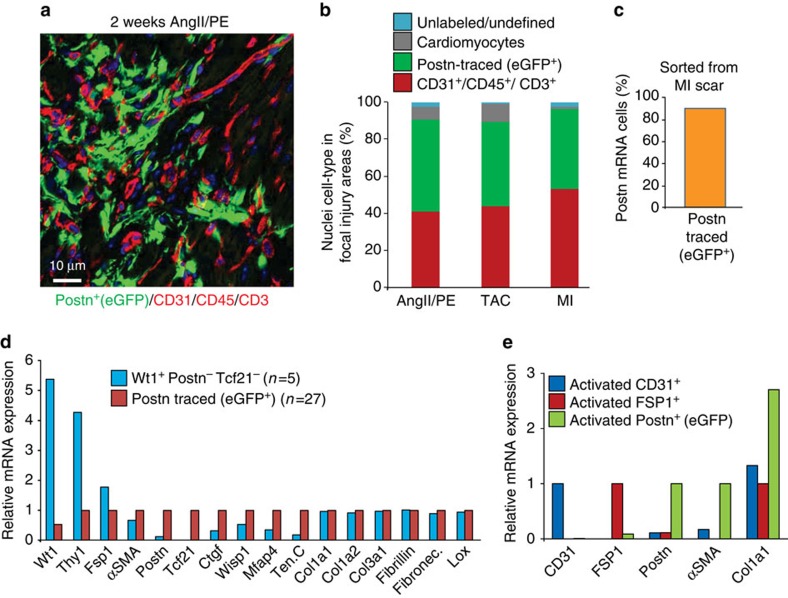
Periostin lineage tracing accounts for essentially all the myofibroblasts in the heart.(a) Representative histological image of an area of focal fibrosis in the hearts of PostnMCM/+; R26-eGFP mice 2 weeks after Ang/PE infusion. Immunohistochemistry is shown for CD31/CD45/CD3 in red, myofibroblasts are shown in green (periostin lineage traced), and myocytes can be quantified based on autofluorescence imaging. All cellular staining was matched to nuclei (blue), which (b) generated a quantitative assessment of the total cellularity in the Ang/PE focal injury areas, or focal injury areas with TAC and MI surgery (2 weeks afterwards). Data were averaged from three hearts for each condition with greater than five non-consecutive sections containing at least three infarct zones quantified. (c) Quantification of Postn-traced (eGFP+) cells within Postn mRNA expressing CD31−CD45− cells isolated from the infarct region of PostnMCM/+; R26-eGFP mice generated from single-cell RNAseq analysis. The data show recombination efficiency of the PostnMCM allele. (d) Relative mRNA expression for the indicated genes generated from single-cell RNAseq analysis of 152 cells isolated from the MI injury region, from which 27 were selected as perisotin lineage-traced (eGFP+) myofibroblasts and 5 were averaged as a unique cell type that had an unorthodox fibroblast-like profile and negative for eGFP (Postn). (e) Relative mRNA expression for the genes shown from cells sorted from the MI region (‘activated’) of the heart for CD31 expression, FSP1 expression or periostin expression (eGFP+).